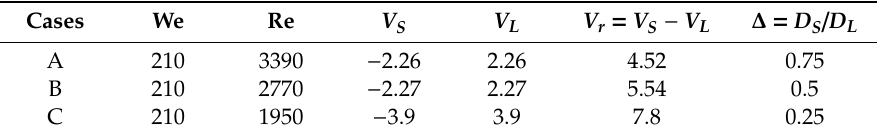
Table 1. Parameter settings in simulation